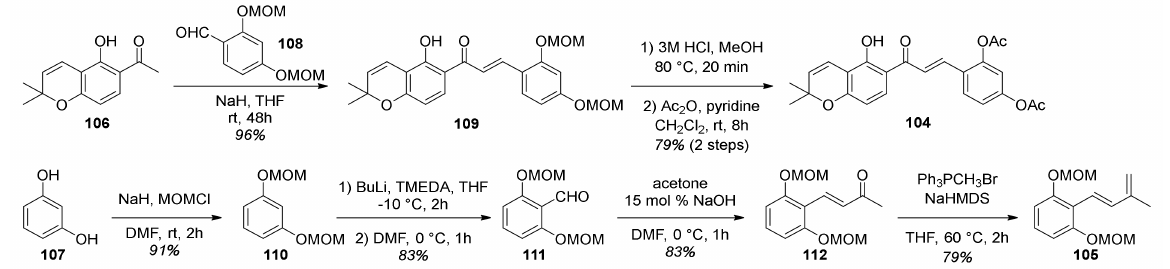
Figure 32. Preparation of diene 105 and chalcone 104 .